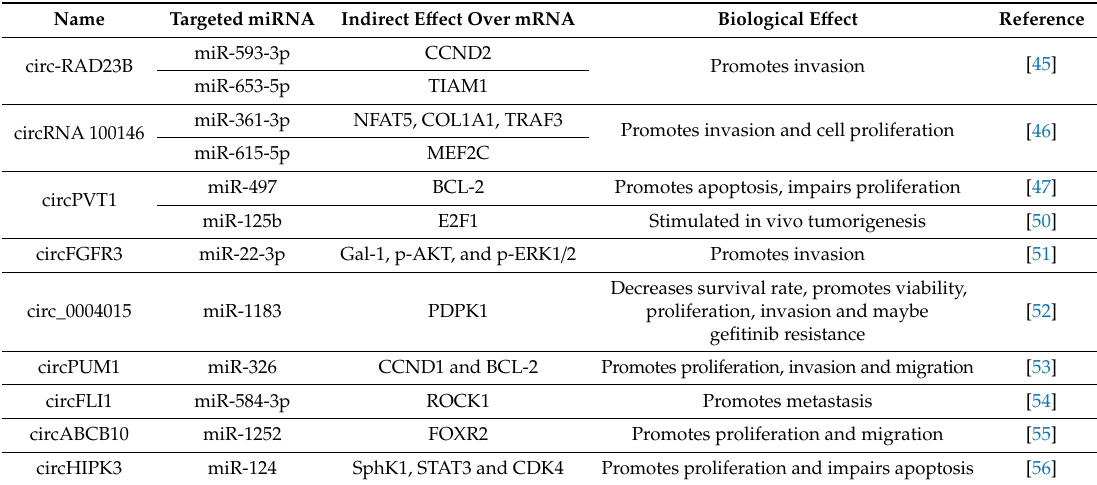
Table 2. Examples of oncogenic circRNAs which act as miRNA sponges in lung